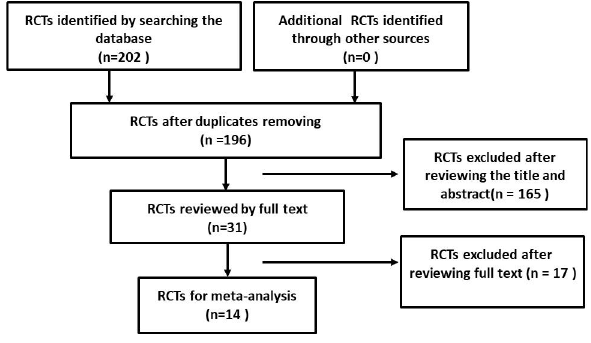
Figure 1: The publication searching follow chart according to preferred reporting items for systematic reviews and